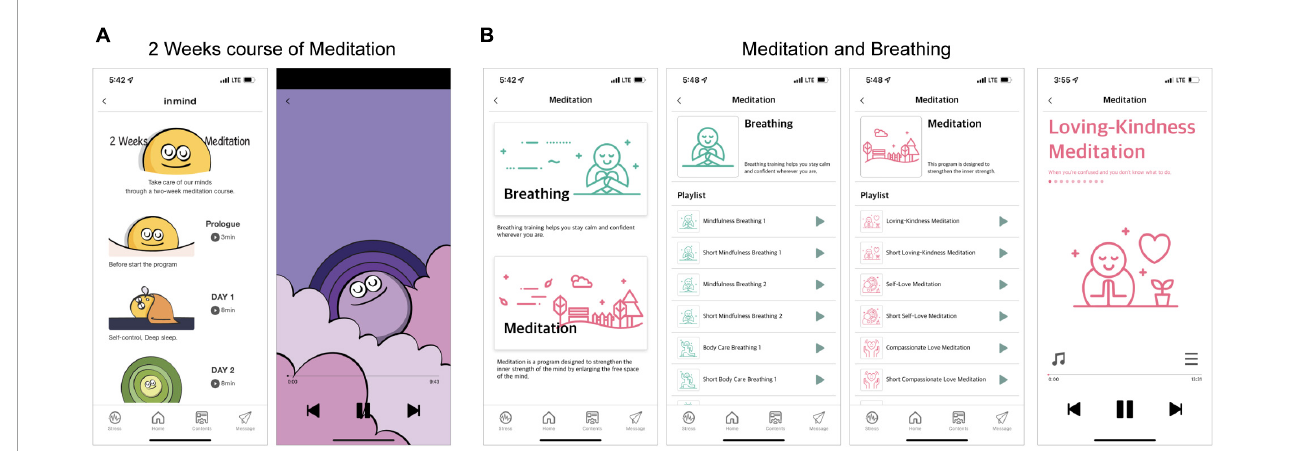
FIGURE4 Screenshots of the meditation module. This module has two parts ( A : “Two weeks course of meditation” and B : “Meditation and breathing”), wherein participants select one of several choices presented as a list and listen to the guided audio recording. The content was presented in Korean, but the examples in this figure are presented in English to aid understanding for international readers.